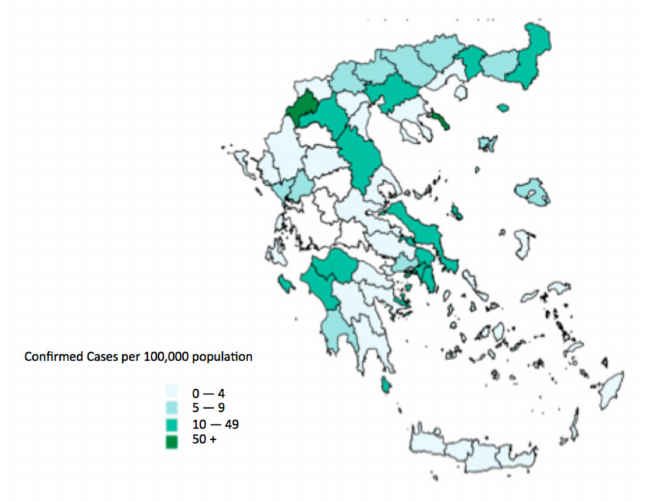
Scheme 4. Map of the geographical distribution of confirmed cases as of 11 April 2020